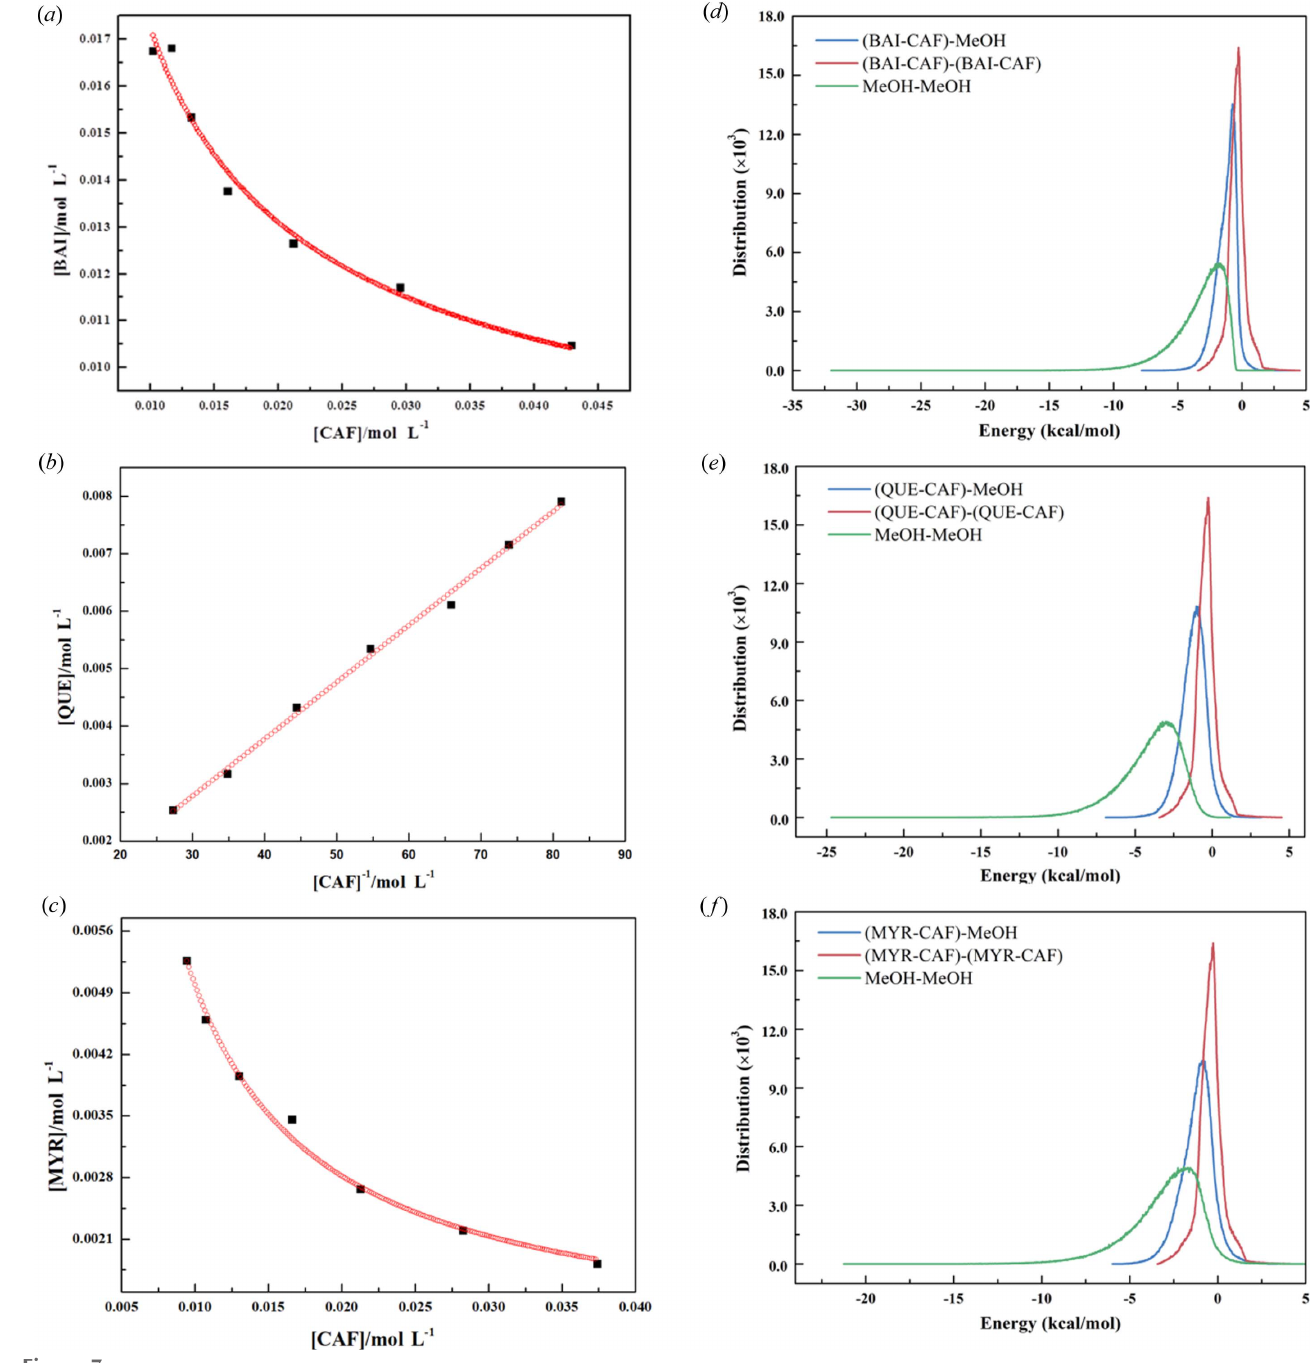
Figure 7 Solubility curve of three cocrystals in methanol at 25 (cid:2) C: ( a ) BAI–CAF, ( b ) QUE–CAF, ( c ) MYR–CAF; and binding energy distributions for the three base-screen pairs ( d ) BAI–CAF, ( e ) QUE–CAF, ( f ) MYR–CAF with no peaks, indicating that only the BAI-II hydroxyl groups could be used as hydrogen-bond donors to form a strong O— H (cid:9) (cid:9) (cid:9) N hydrogen bond in cocrystal 1. The hydroxyl groups of QUE and MYR are simultaneously engaged in O—H (cid:9) (cid:9) (cid:9) N interactions with the nitrogen atom of the CAF molecule, and both showed sharp spikes in the upper (donor) regions of the fingerprint plot of QUE and MYR [Figs. S4( c ) and S4( d )]. The contribution value of O—H (cid:9) (cid:9) (cid:9) N, a strong hydrogen bond, in